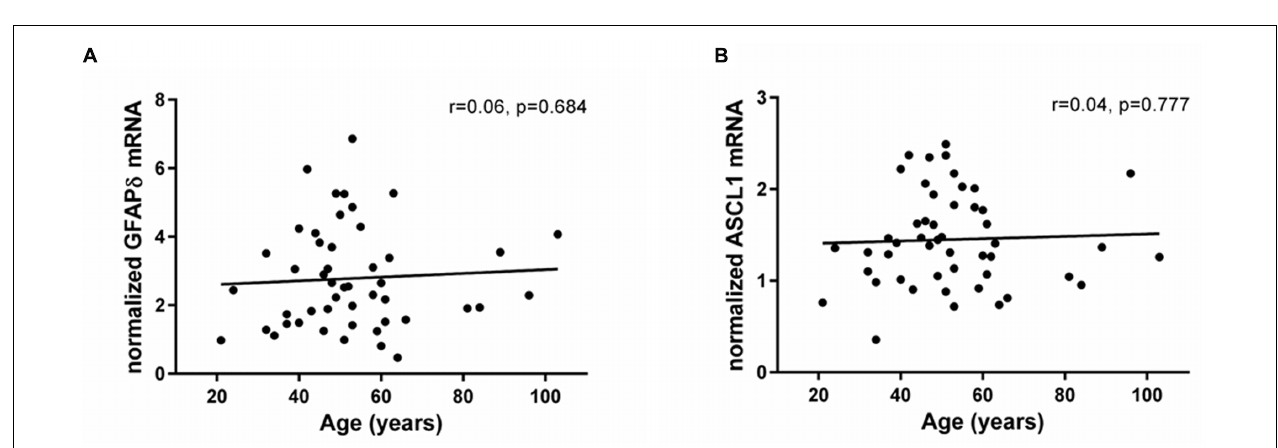
FIGURE 2 | Expression of stem and precursor cell markers in the SEZ remained stable throughout adulthood. Stem cell (GFAP δ ) and neuronal precursor (ASCL1) transcripts were assessed by qRT-PCR and normalized to the geometric mean of two housekeeping genes. GFAP δ (A) and ASCL1 mRNAs (B) were reliably detected in all individuals and remained stable during aging. r, Pearson’s product-moment correlation coefficient.